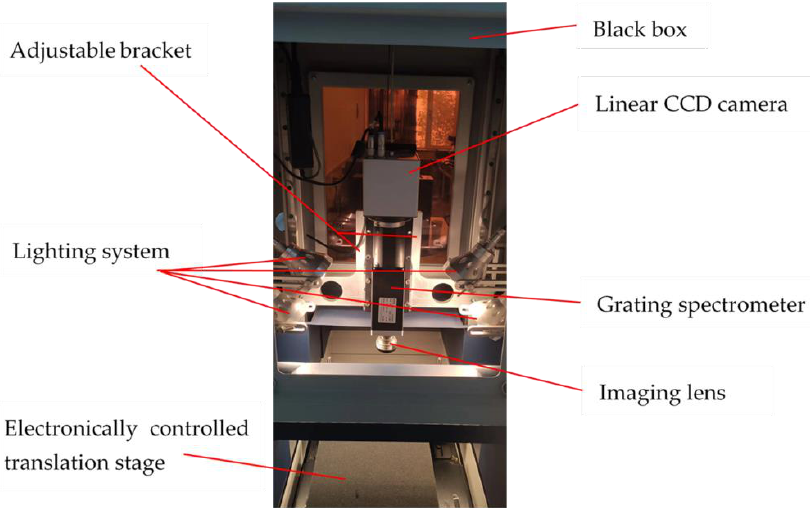
Figure 2. Near-infrared hyperspectral reflectance system.